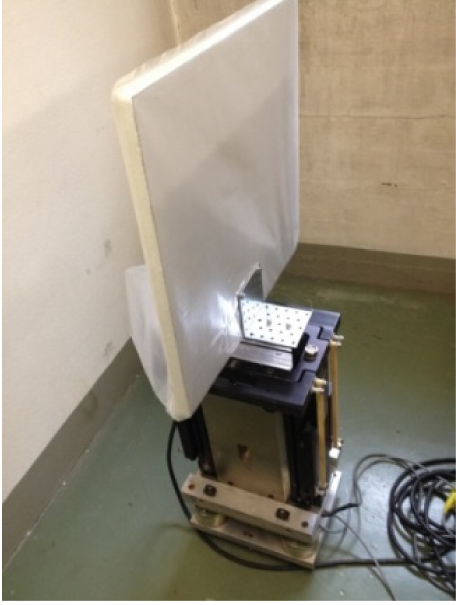
Figure 3. Vibration test setup with silica aerogel board fixed to a shaker with a plastic bag for dust collection. Image: Empa.